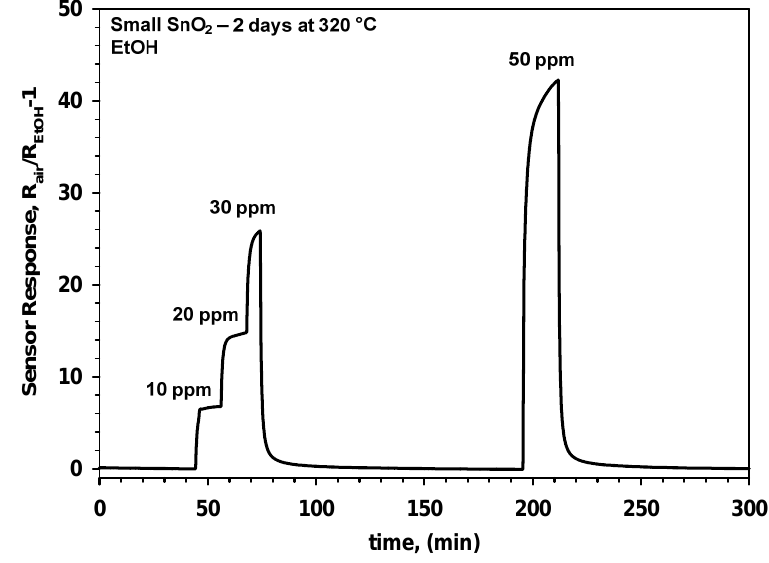
Figure 5. Response of a gas sensor made of small SnO prior stabilization upon two days at 320 °C in dry